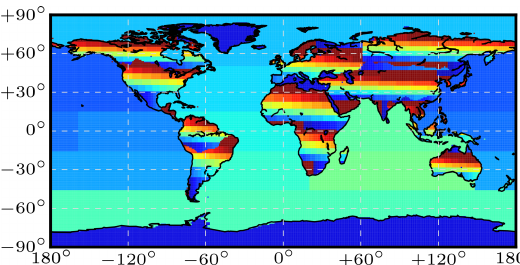
Figure A2. Basis functions that describe the 487 regions where we estimate methane emissions, including 476 land regions and 11 oceanic regions.